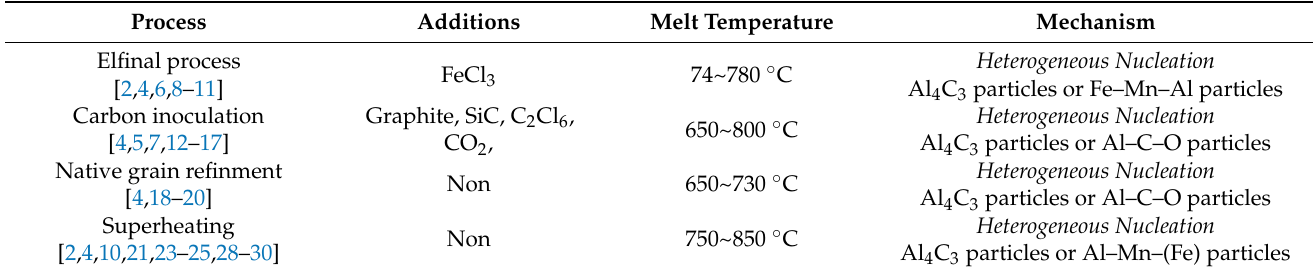
Table 1. Summary of grain refining processes of aluminum-bearing magnesium